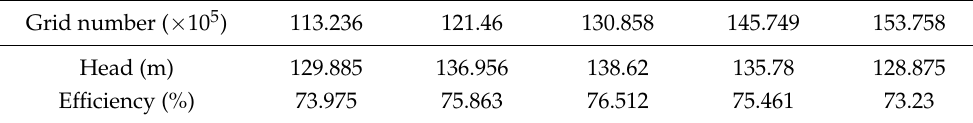
Figure 4. The blade contour of y +. Table 2. Results of the grid independence